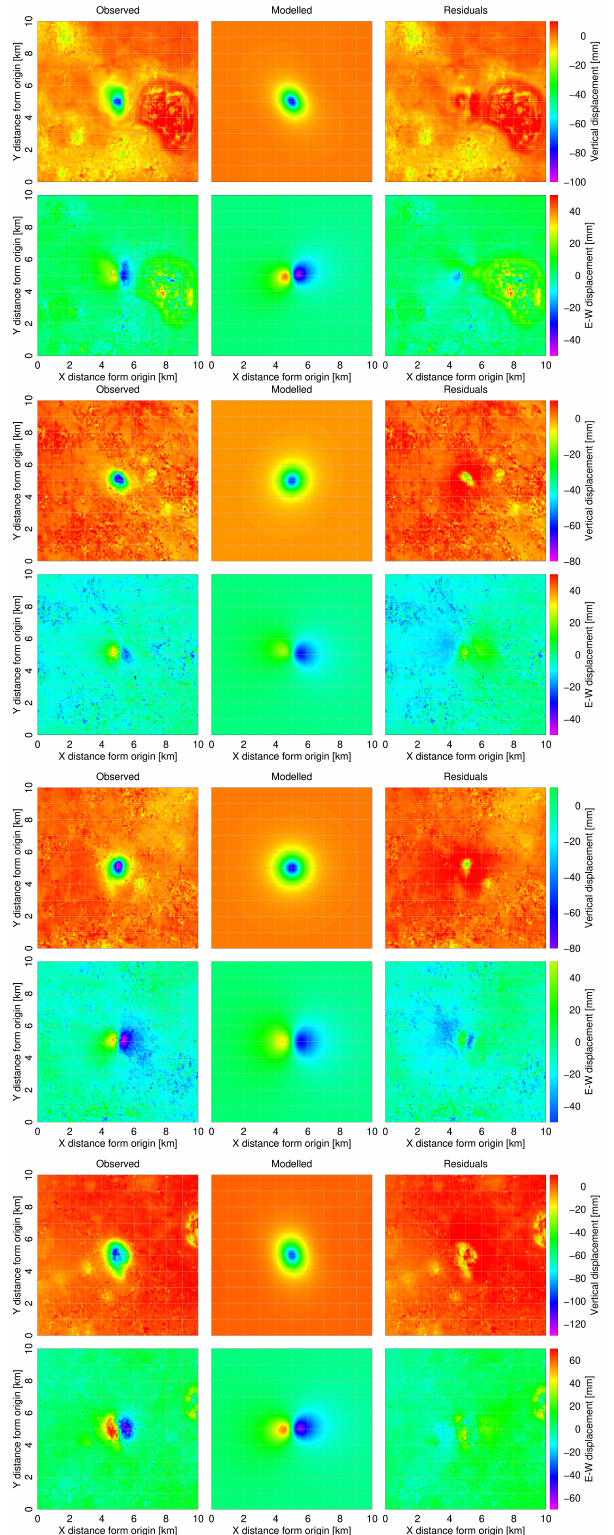
Figure 8. The modeling result for the analyzed mining tremors. Both vertical and horizontal displacements are shown for each